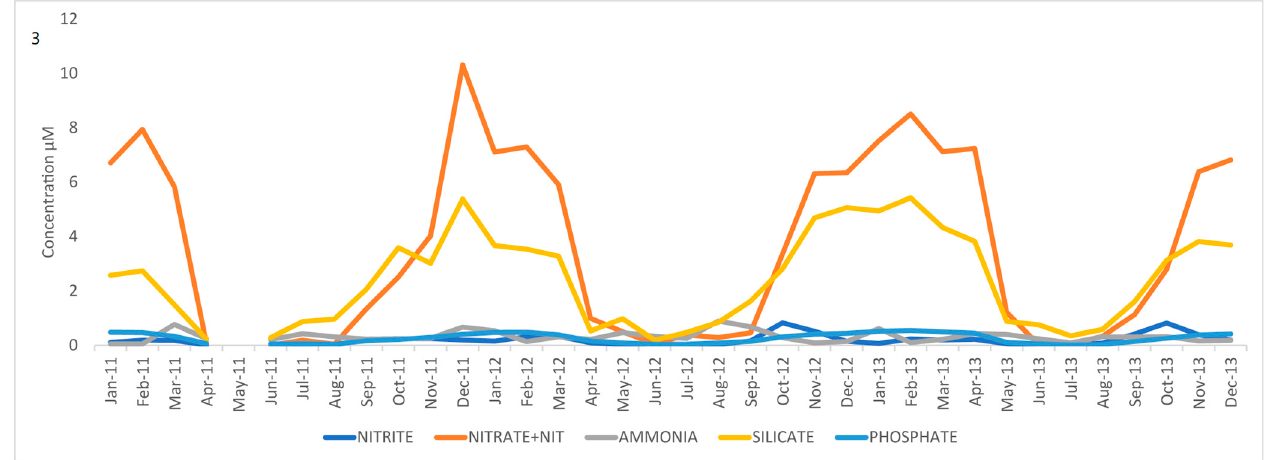
Figure 2. Panel (1) Sea surface temperatures from 2000–2020. Panel (2) Weekly measurements of Nitrate (A), Nitrite (B), Phosphate (C) and Silica (D) concentrations from the WCO L4 station from 2000–2022. Panel (3) Nutrient levels in the period 2011–2013, including nitrate and nitrite (Nitrate + Nit).